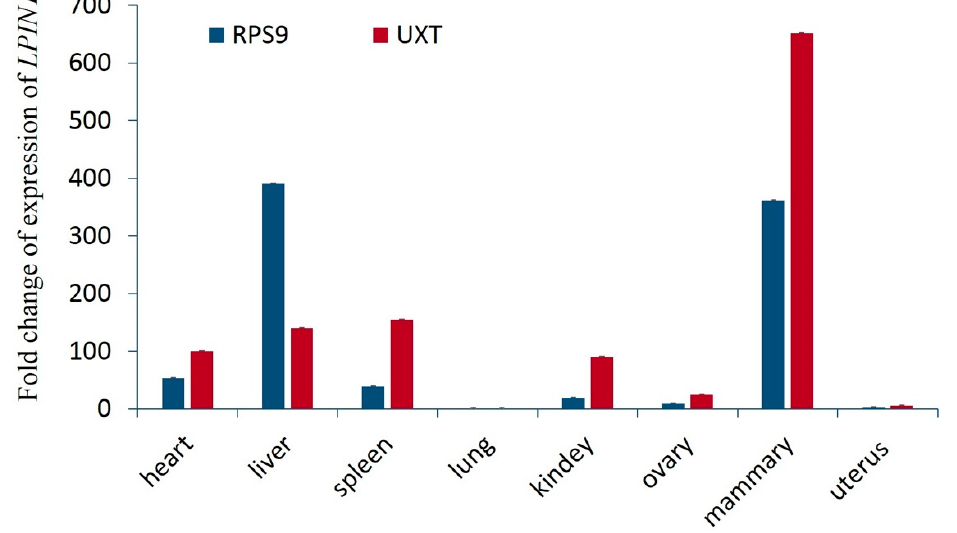
Figure 2. Expression profiles of LPIN1 gene in eight different tissues. RPS9 and UXT were the two reference genes.